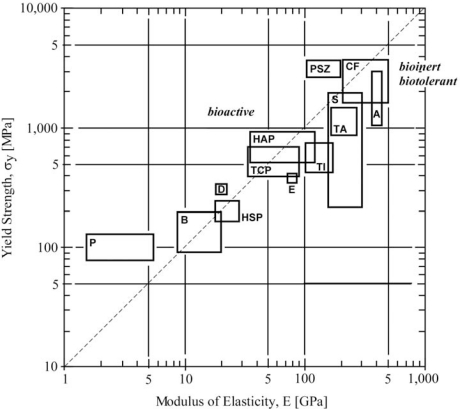
Relationship between yield strength and modulus of elasticity of various biomaterials.P: polymeric materials, B: bone, D: dentin, HSP: high strength polymers (e.g., Kevlar), E: enamel, TCP: tricalcium phosphate, HAP: hydroxyapatite, TI: commercially pure titanium, TA: titanium alloys (e.g., Ti-6Al-4V), S: 304-series stainless steel, PSZ: partially stabilized zirconia, A: alumina, CF: carbon fiber.